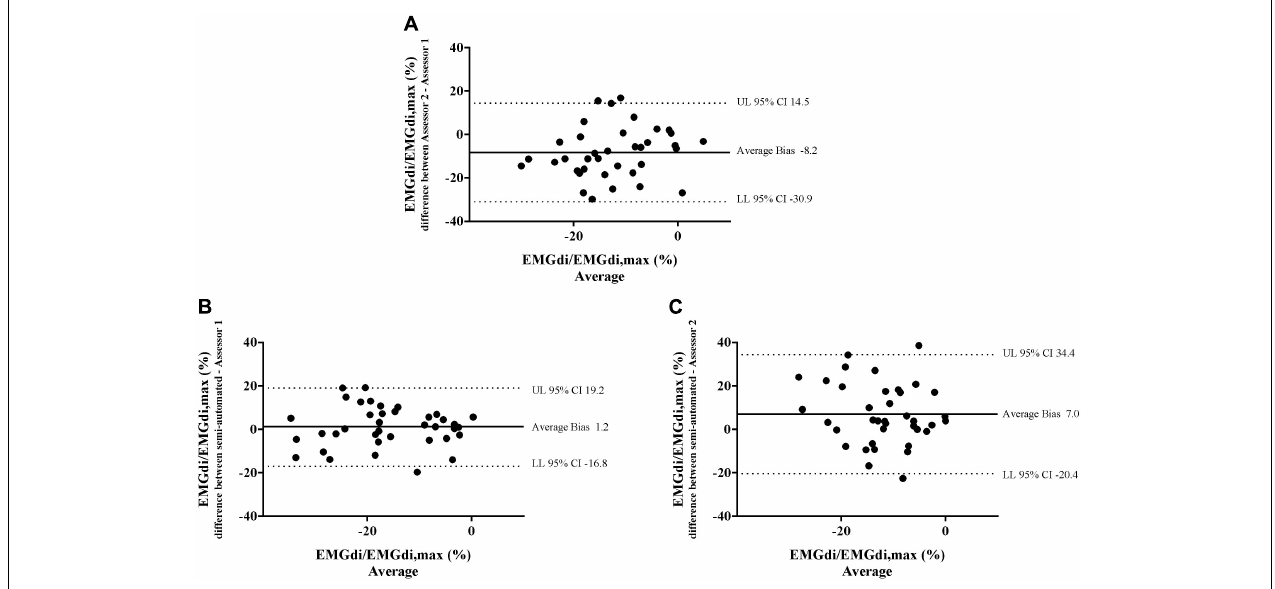
FIGURE 8 | The results from the manual method by two assessors and the semi-automated method are compared in four patients in each minute during CWR cycling test pre and post the intervention. Bland-Altman plots of the pre/post differences in EMGdi/EMGdiMax% calculated from the manual method by two assessors (A) ; the semi-automated method and the manual method by assessor 1 (B) ; the semi-automated method and the manual method by assessor 2 (C)